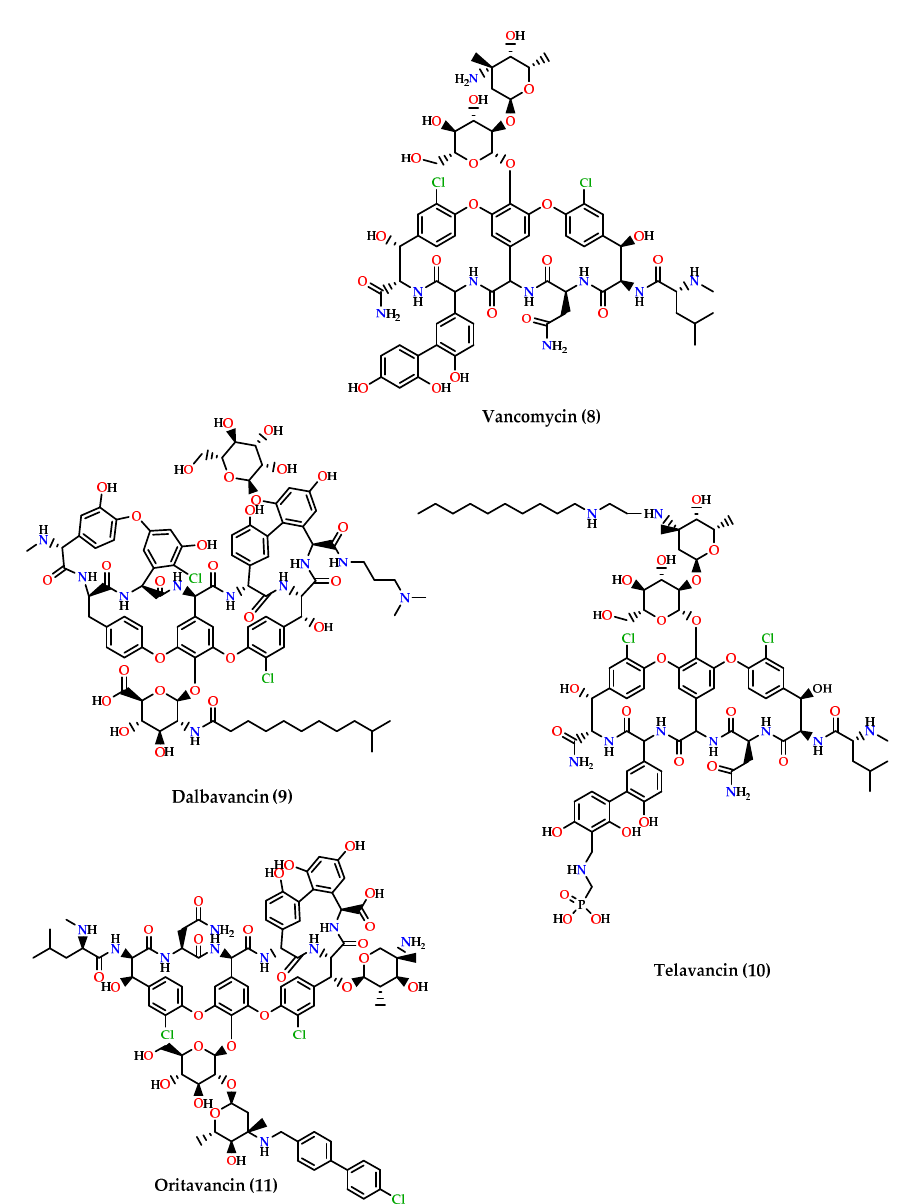
Figure 4. Chemical structures of vancomycin (8), dalbavancin (9), telavancin (10), and oritavancin